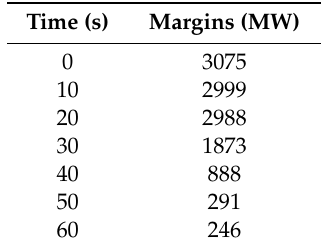
Table 3. Margins with each load character curve.